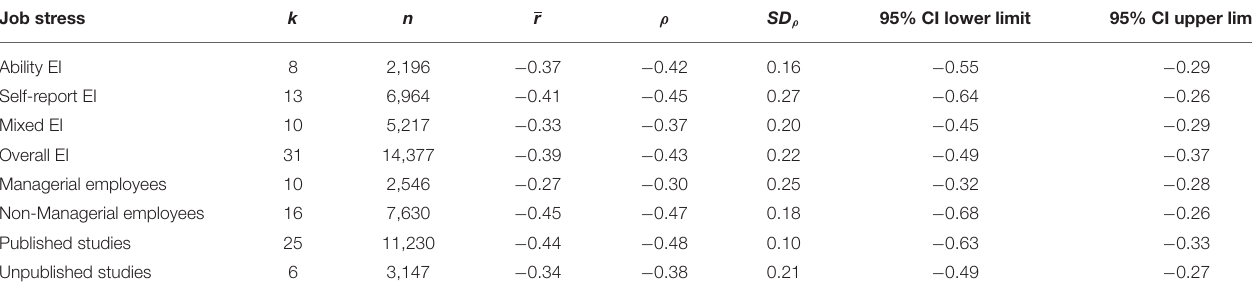
TABLE 7 | Meta-analytic results of the relationship between EI and job stress. Job